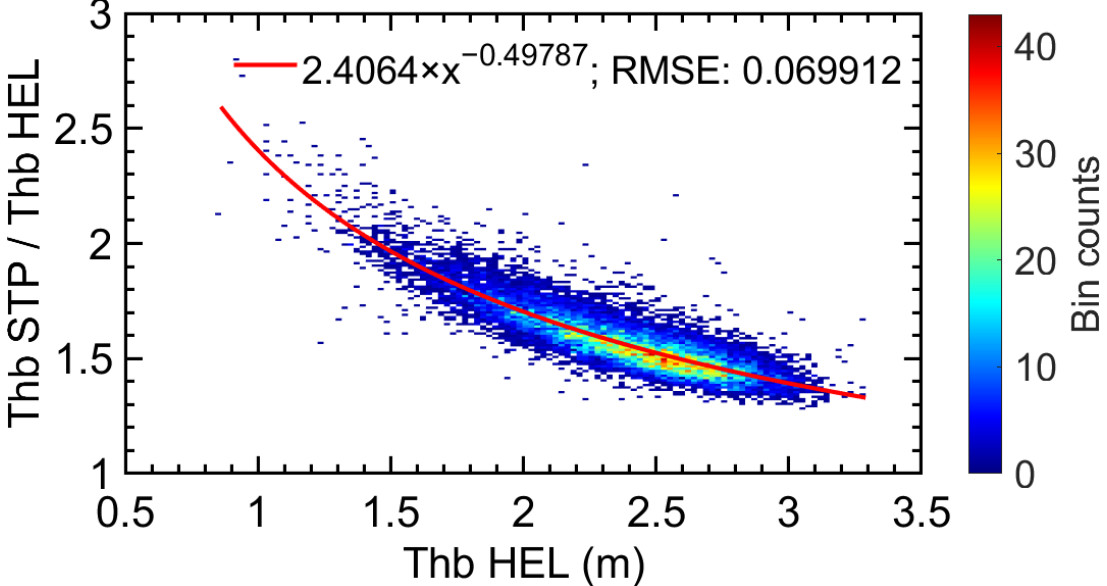
Table 2. M 2 and S 2 amplitudes as well as spring and neap tidal range resulting from M 2 and S 2 interference for gauges Helgoland (HEL), beacon A (BKA) and St. Pauli (STP) as well as amplifica-